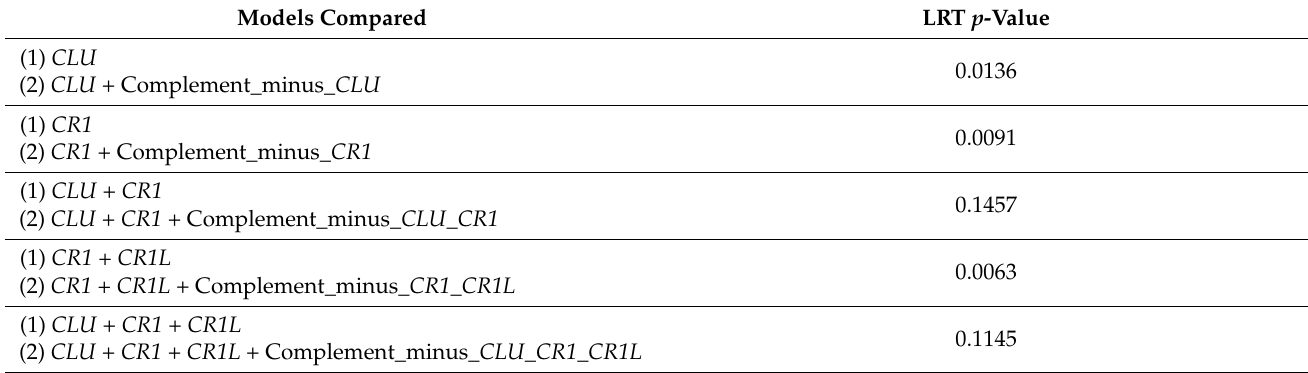
Table 4. Likelihood ratio test (LRT) comparing gene-set risk